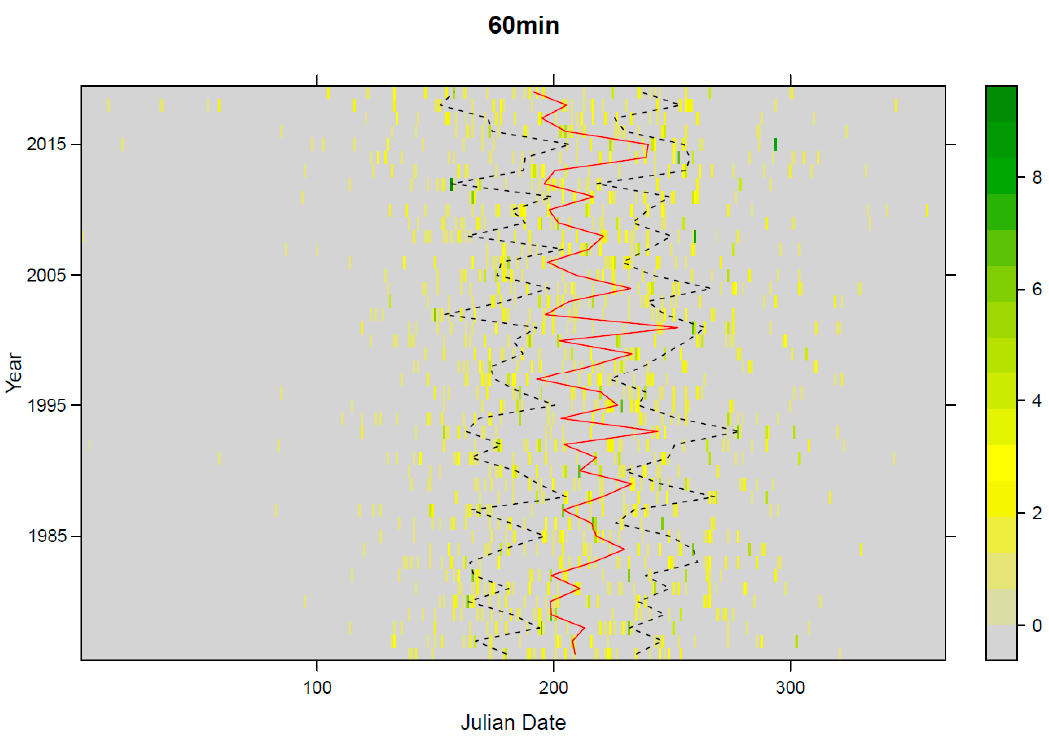
Figure 6. Clustering of the AM5 events for the 60 min rainfall duration. Red line shows the median Julian date and dotted black lines show 25% and 75% Julian date.